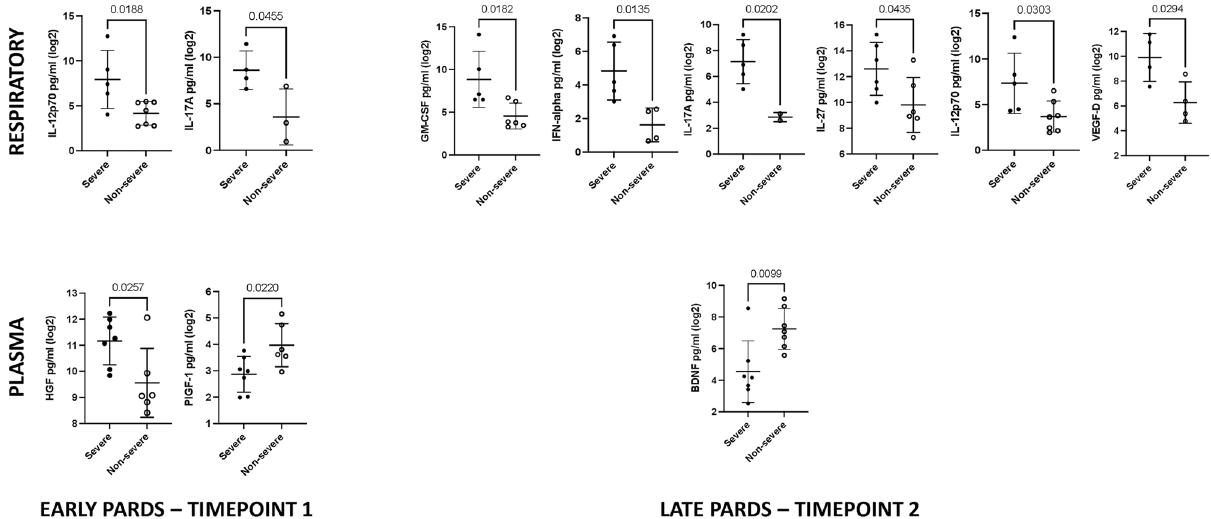
Figure 2. Respiratory and plasma cytokine concentration in severe and non-severe PARDS at timepoint 1 and 2. p -value indicates the difference between the two severity groups using t-test.